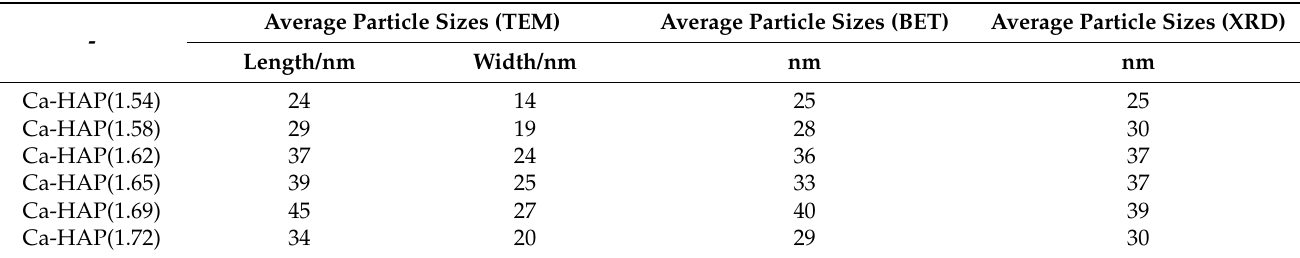
Figure 2. Transmission electron microscopy (TEM) images of the Ca-HAP catalysts. ( a ) Ca-HAP(1.54), ( b ) Ca-HAP(1.58), ( c ) Ca-HAP(1.62), ( d ) Ca-HAP(1.65), ( e ) Ca-HAP(1.69), ( f ) Ca-HAP(1.72), and ( g ) commercially available hydroxyapatite (HAP-100). Table 2. Average particle sizes of prepared Ca-HAP